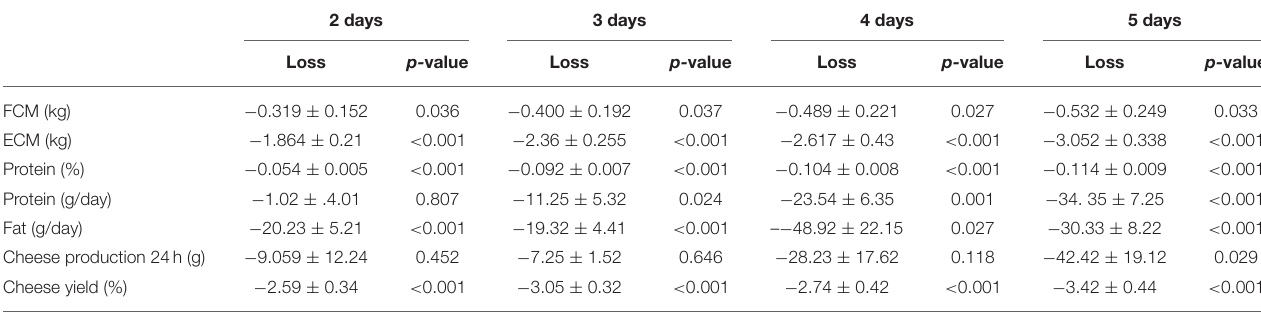
TABLE 2 | Relative variation of fat-corrected milk (FCM; kg), energy-corrected milk (ECM; kg), protein content (%), protein yield (g/day), fat yield (g/day), cheese production at 24h (g) and cheese yield (%) after heat waves lasting 2, 3, 4, and 5 consecutive days, in comparison with the losses estimated after a single day of daily maximum temperature–humidity index (THI) over the